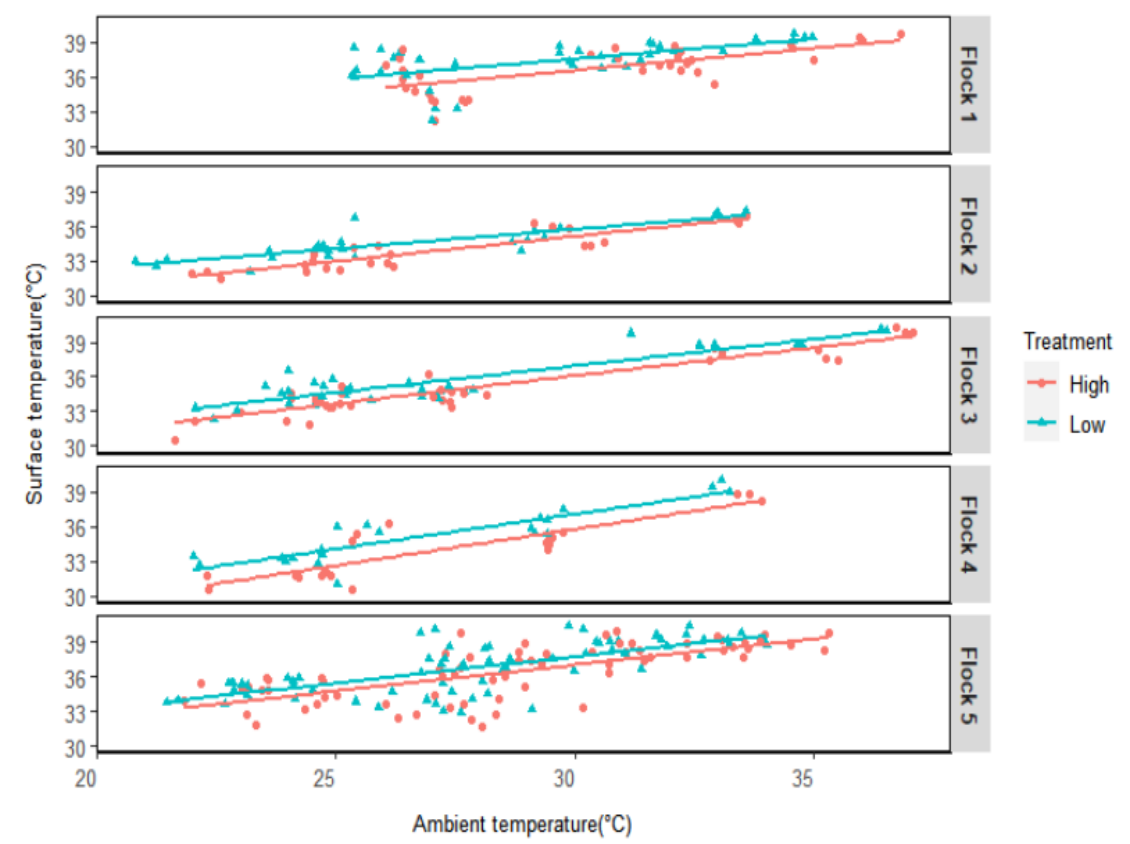
Figure 3. Changes in heavy broilers’ surface temperature with environmental temperature.